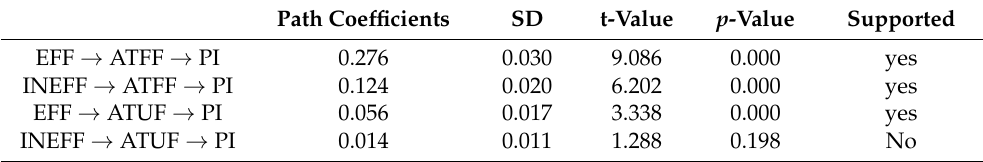
Table 6. Mediation